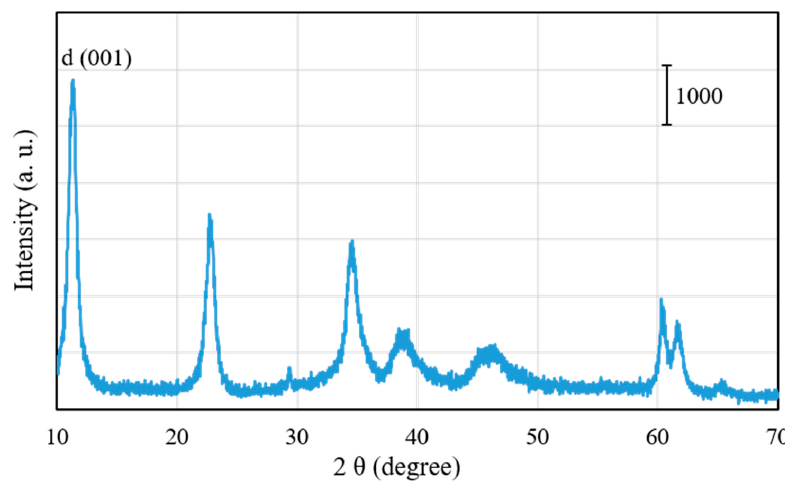
Figure 2. X ‐ ray diffraction (XRD) patterns of Pd 0.016 Mg 3 Al(OH) 16 CO 3 ∙ x H 2 O after drying at 100